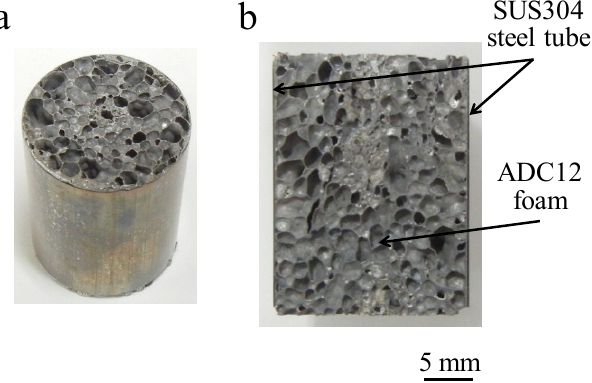
Figure 4. Fabricated Al foam-filled steel tube: ( a ) Compression test specimen; ( b ) Cross-sectional image of ( a